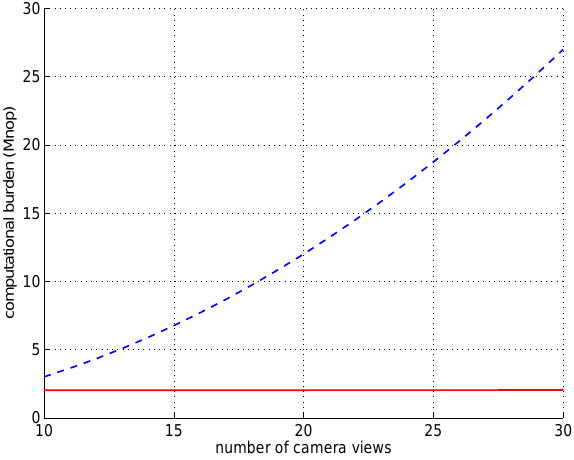
Figure 4: Comparison of the computational complexity (ex- pressed in number of operations (nop) of one iteration of the SVD (blue dashed line) and of the ISVD (red solid line) for a matrix W with size 3 m × n